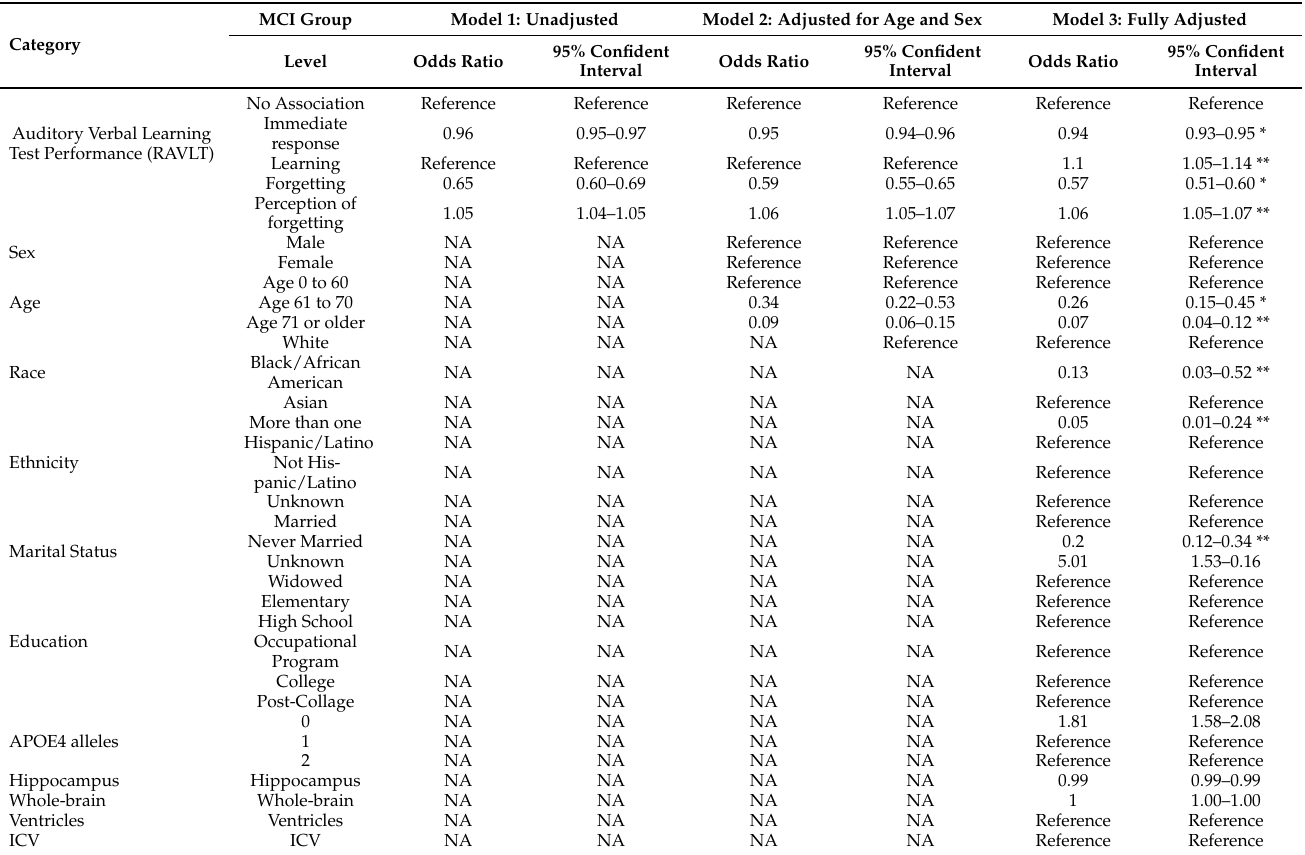
Table 2. Associations between RAVLT test for learning, forgetting, immediate response, and percep- tion of forgetting and MCI with low and high risk for RAVLT test alone or fully adjusted. Covariates with symbol ** are most negatively associated covariates compared with only one symbol